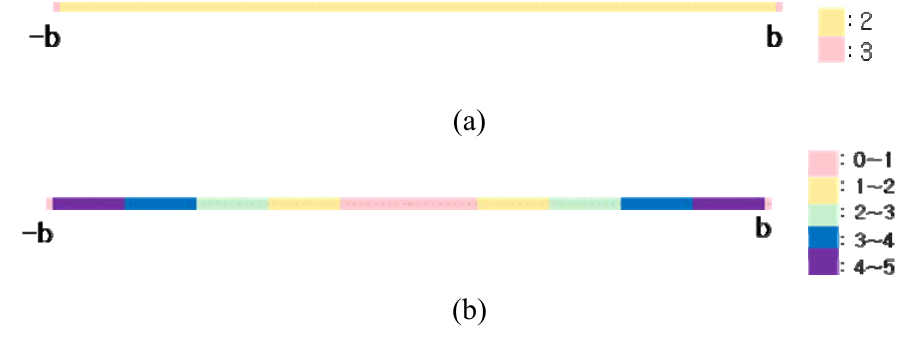
Figure 6. (a) Number of detected tags in worst case (b) Scale of error in worst